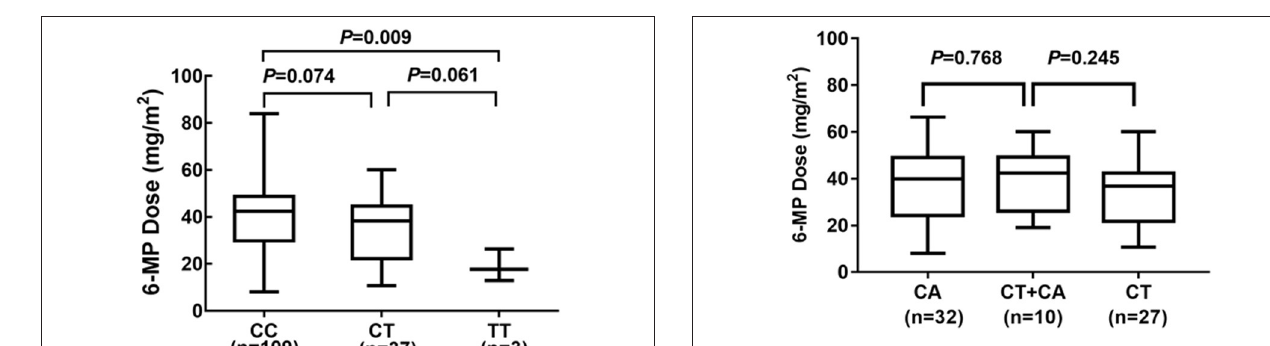
FIGURE 5 | 6-MP dose for patients with ITPA c.94C > A (CA) and NUDT15 c.415C > T (CT) 27 patients with CT, and 6-MP dose 33.56 ± 2.70 mg/m 2 ; 32 patients with CA, and 6-MP dose 37.25 ± 2.80 mg/m 2 ; 10 patients with combined CT and CA, with 6-MP dose 39.62 ± 4.24 mg/m 2 . 6-MP dose had no significant difference between these three